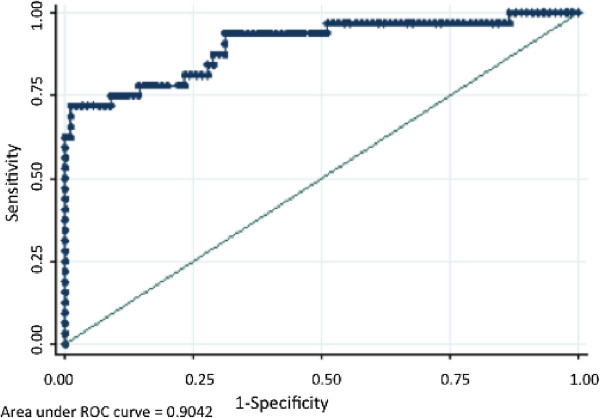
Validation of the WST8/1-methoxy PMS assay (AUC). Receiver operating characteristic curve for the performance of the WST8/1-methoxy PMS test for G6PD diagnosis in the field study in Uganda.